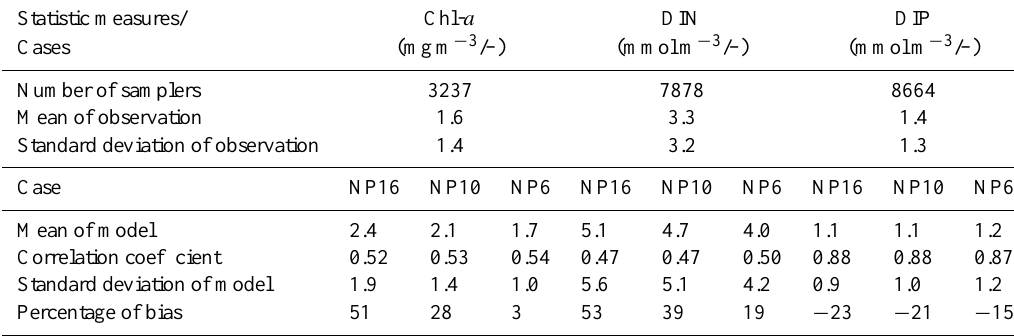
Table 4. Statistic comparison between modeled results and observed data for the Baltic